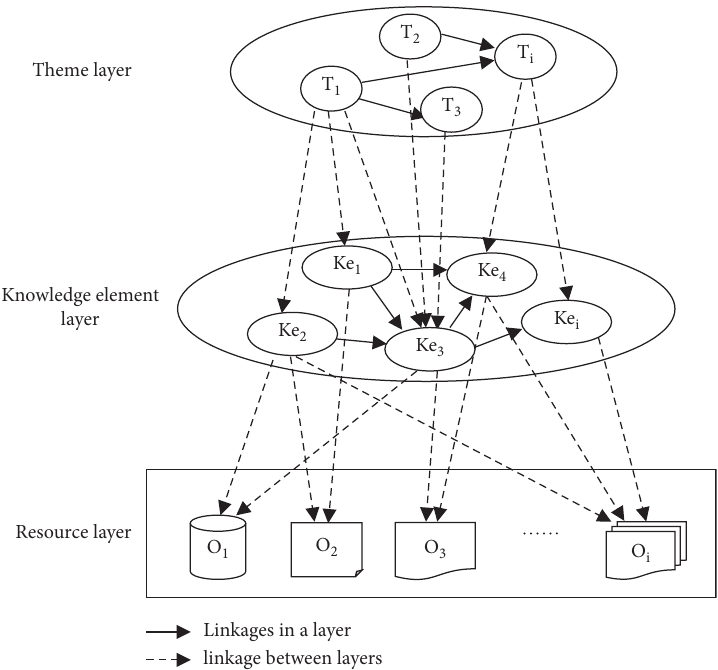
Figure 1: Knowledge map and linkages between knowledge